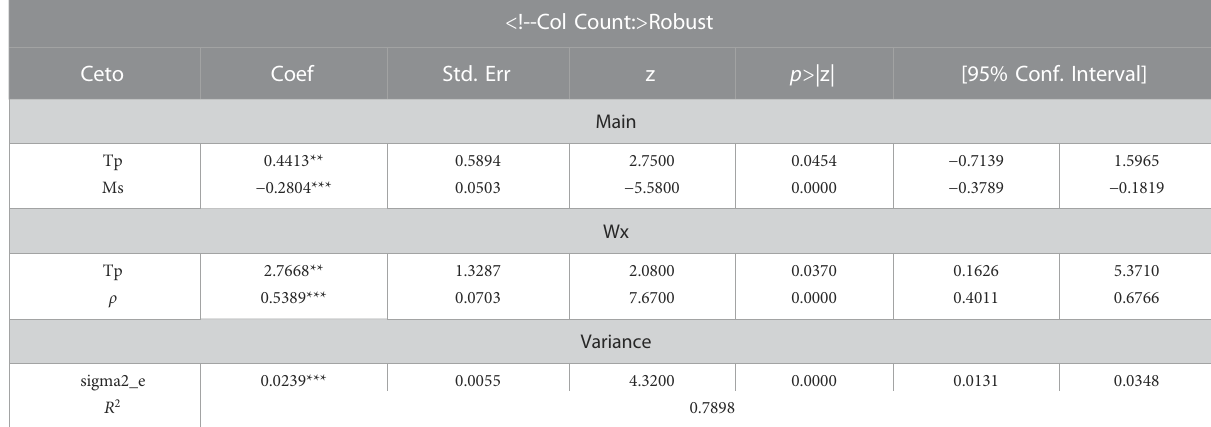
TABLE 10 Regression results of SDM with fi xed